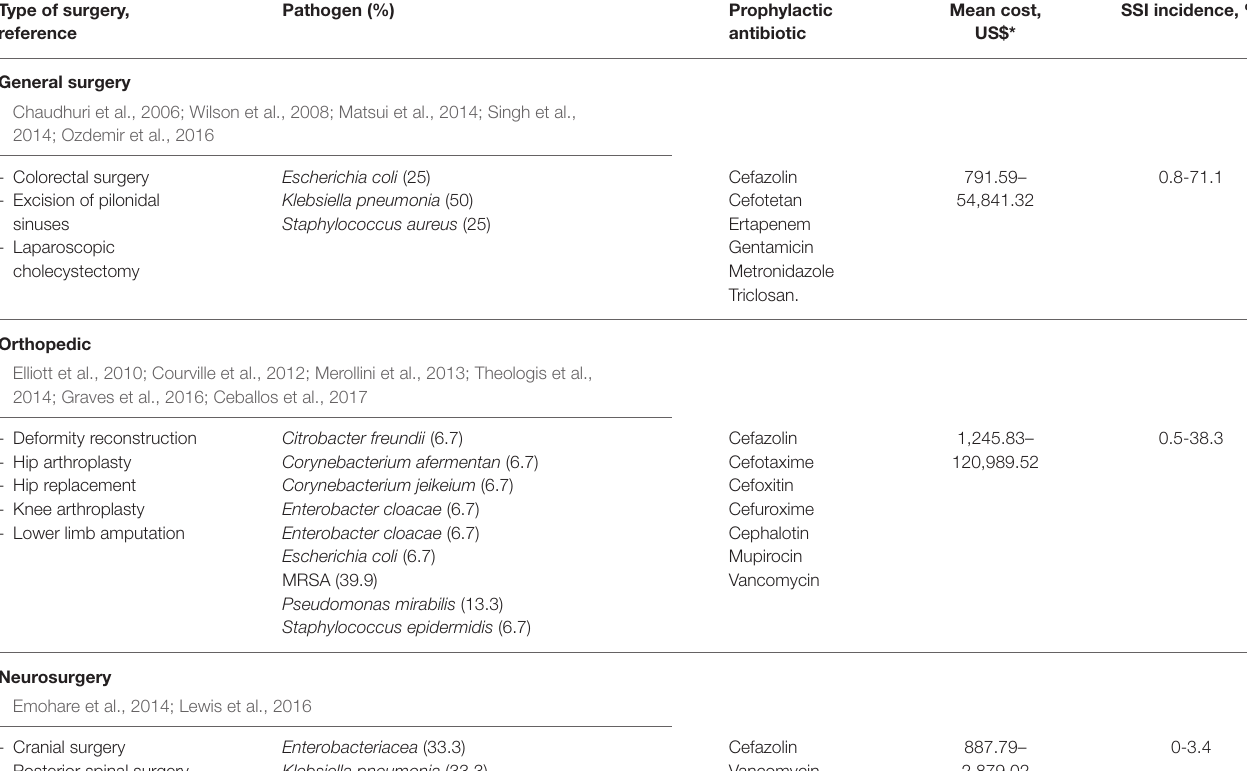
TABLE 5 | Characteristics of pathogens, prophylactic antibiotic, mean cost and SSI incidence in each surgical procedure. Type of surgery,